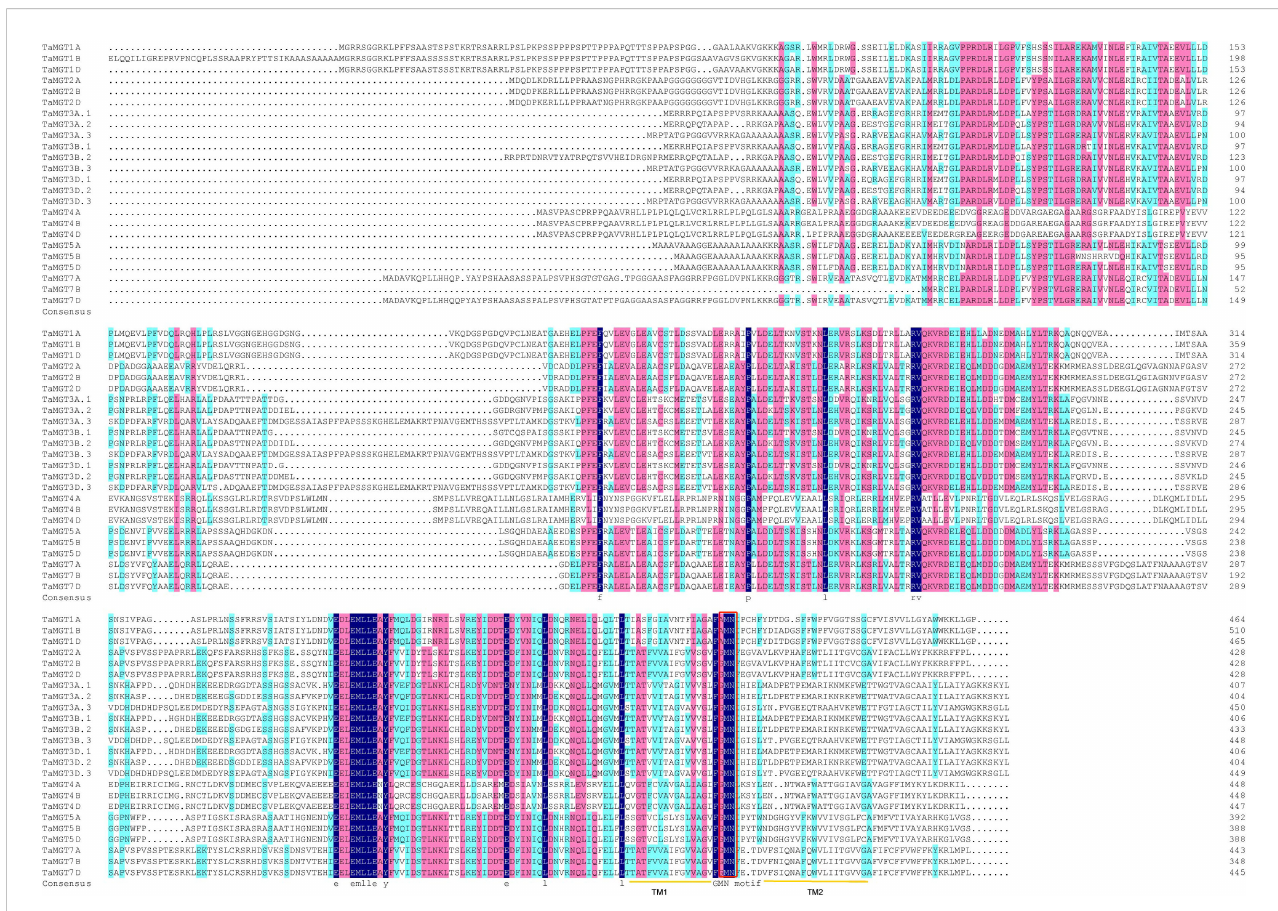
FIGURE 1 Multiple sequence alignment of TaMGTs. Multiple alignments were performed using DNAMAN software. TM domains are marked with orange lines. Conserved GMN motif is indicated by Red